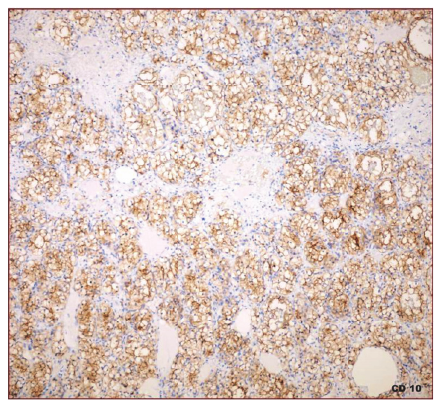
Figure 4: Clear cells, positively stained by CD10 ( ×